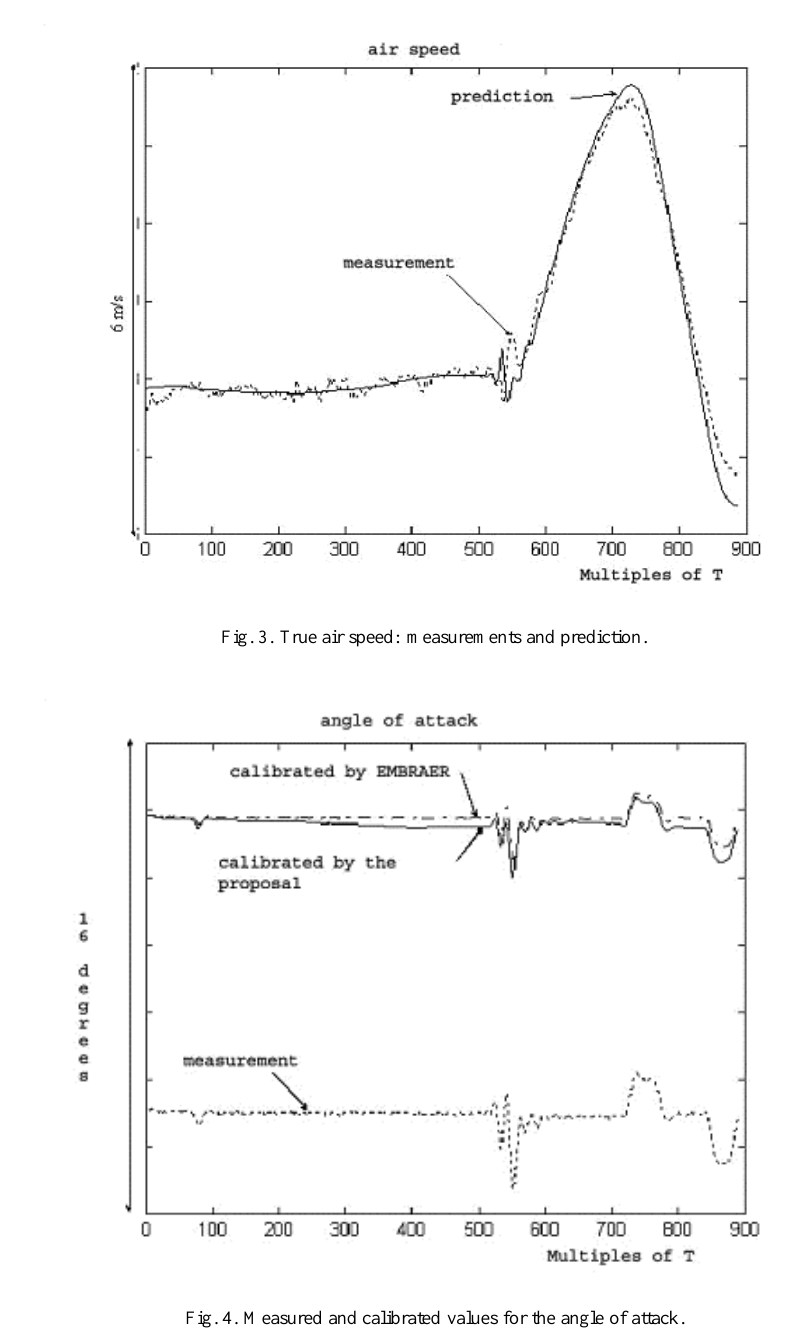
Fig. 4: the values measured by the aircraft sensors, the values calibrated by the aerospace industry through